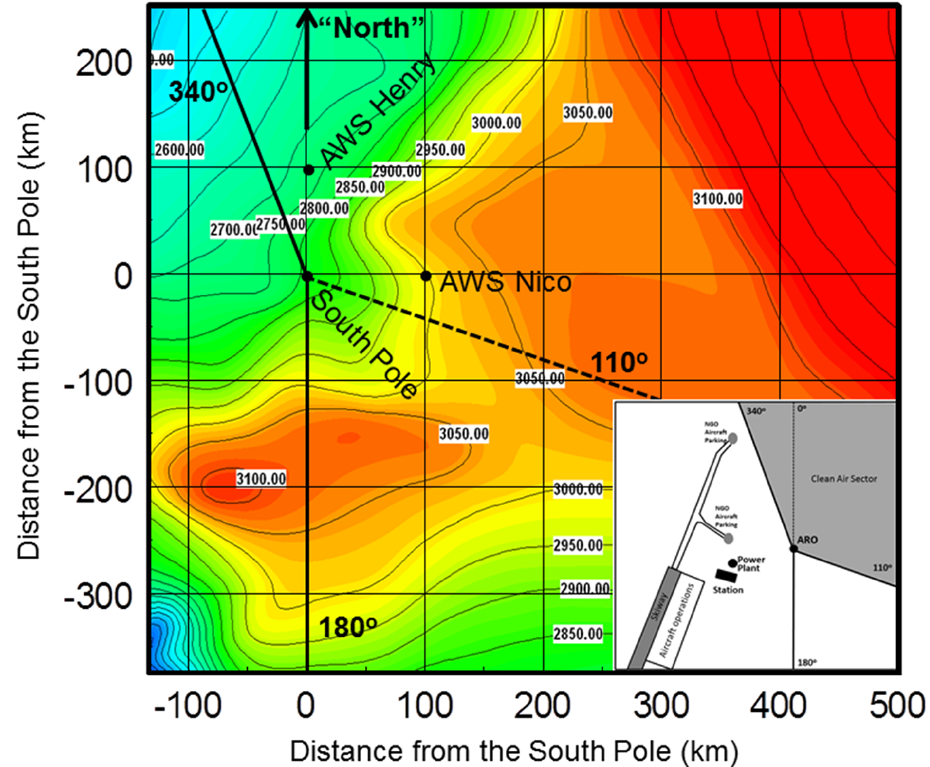
Figure 6. Local terrain around the SP and the location of station facilities and the clean air sector (map insert). Contour interval is 50m. The clean air sector extends from 340 to 110 ◦ , whereas the major station activity is located between 340 and 210 ◦ . Note that the prevailing surface wind (northeasterly) is actually along terrain isopleths upstream of the station except for the last 50km. Local “downslope winds” come from directions generally between east and south. Automatic Weather Stations (AWS) Nico and Henry, which have been operating since 1993 are also indicated lying about 100km from the SP. Highest NO is observed when the wind directions are from the direction of the terrain “gap” to the southeast of the